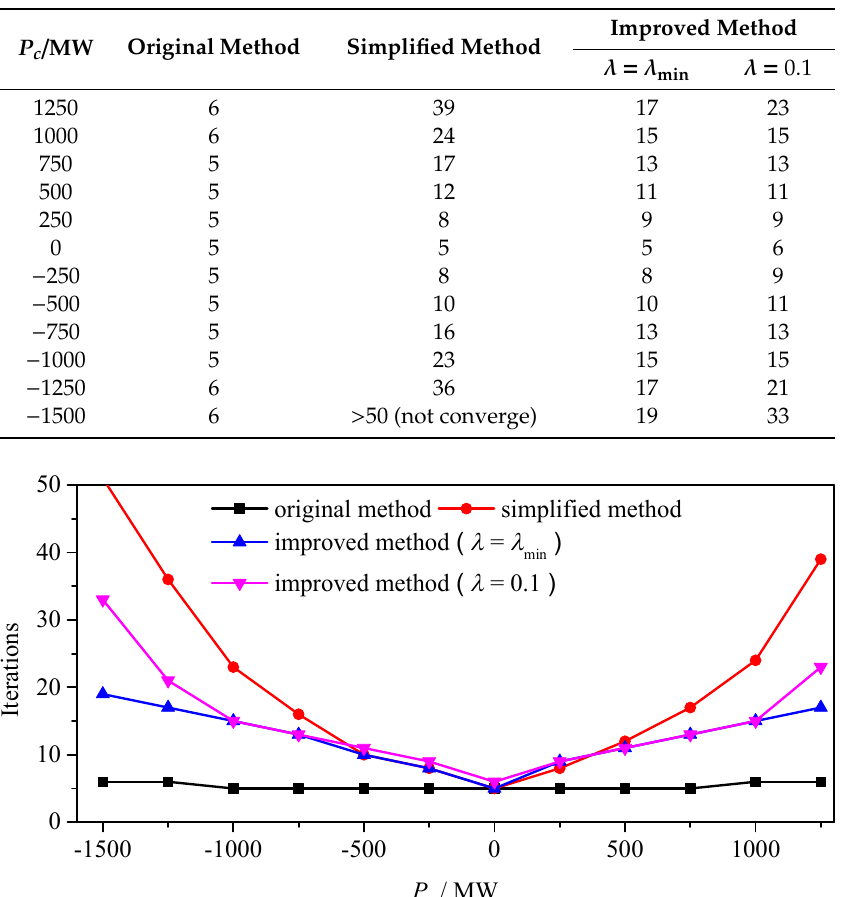
Table 4. Iteration numbers of the three methods under di ff erent P c .